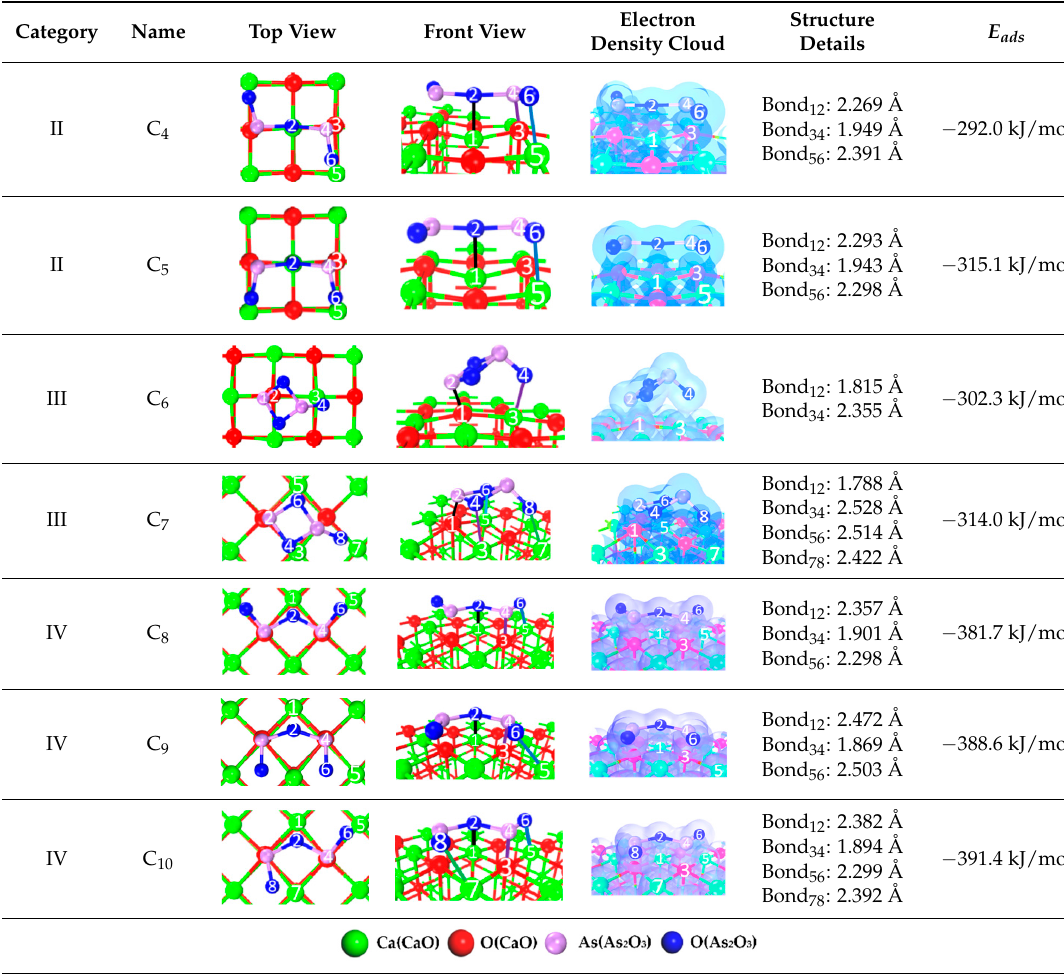
Table 3. Chemisorption structures, adsorption energy, electron density cloud and E